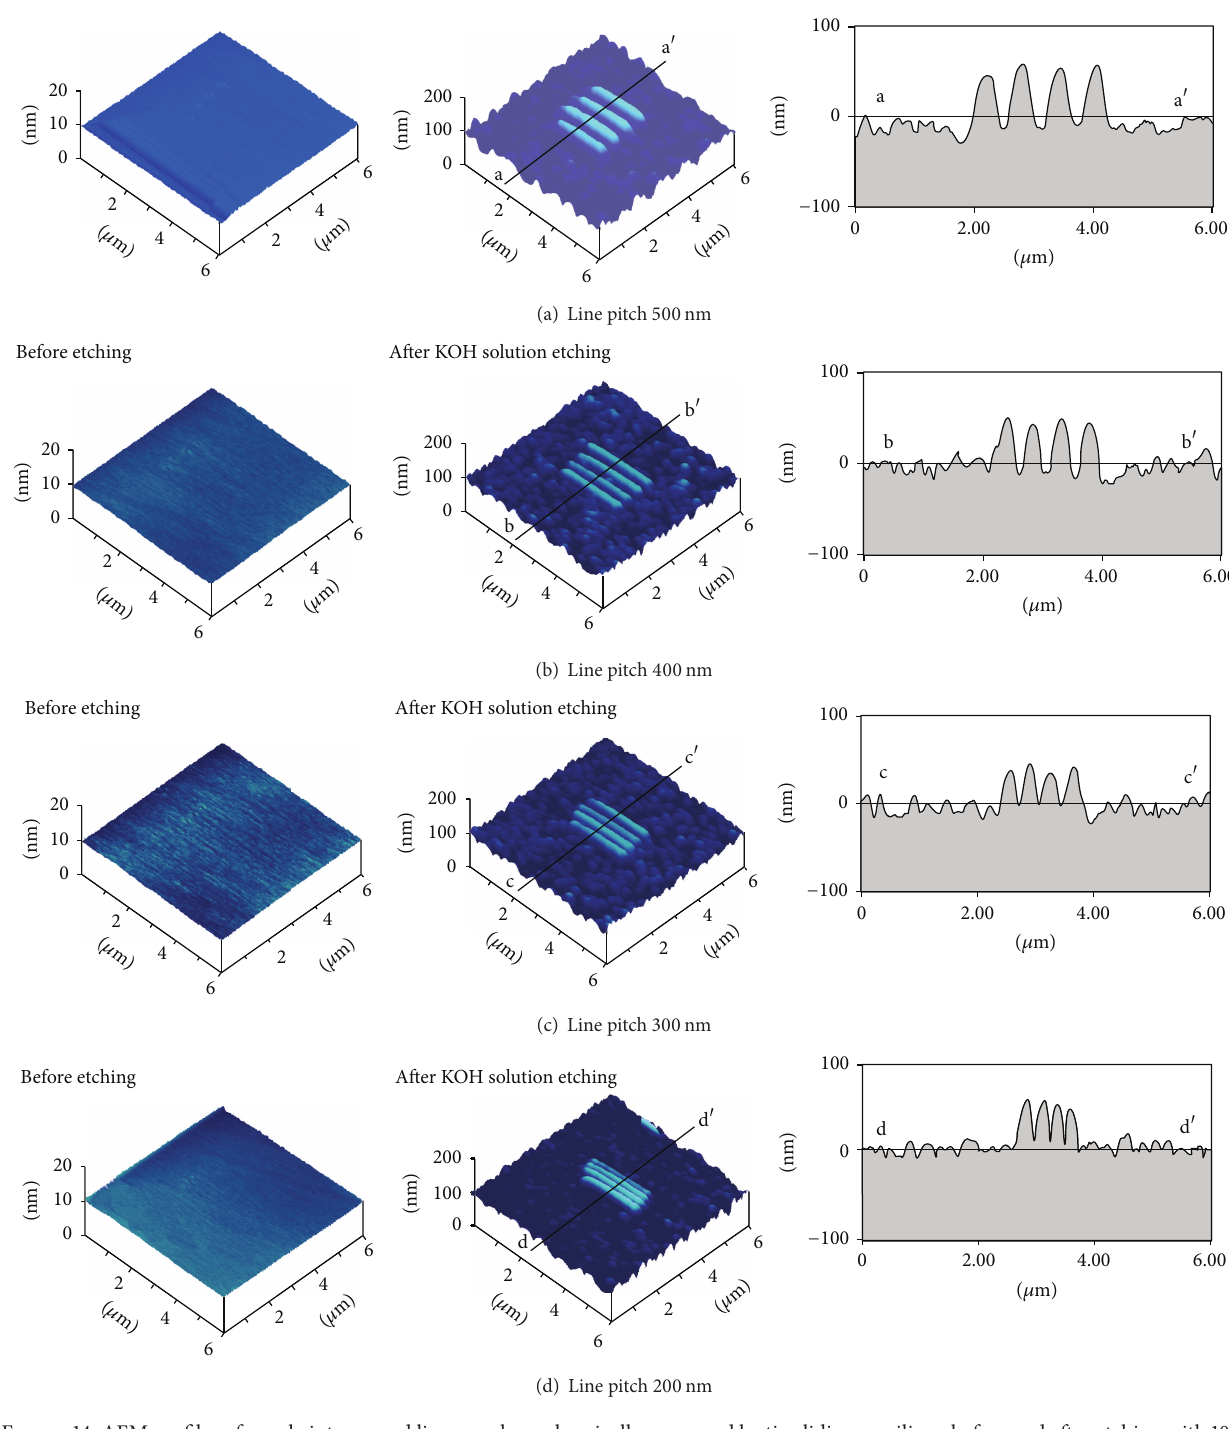
Figure 14: AFM profiles of evenly interspaced lines mechanochemically processed by tip sliding on silicon before and after etching with 10% KOH